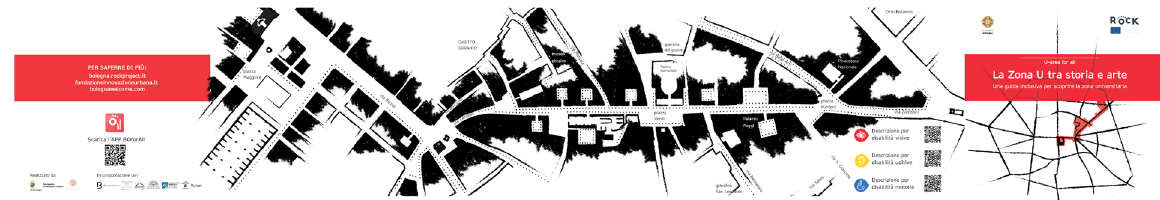
FIG. 5 Orientation and mobility tactile design for the booklet for U-AREA FOR ALL - ROCK BOLOGNA